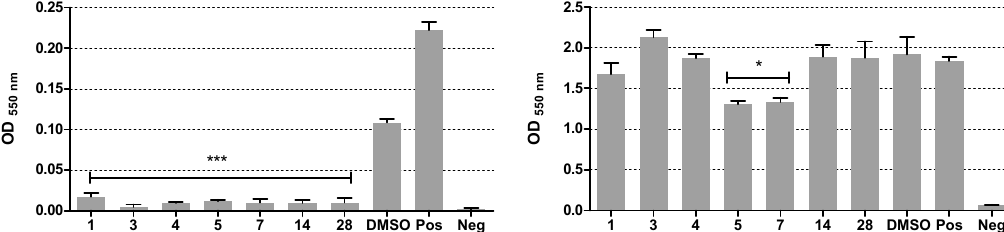
Figure 5. Antibiofilm activity of the selected chalcones on biofilm formation (left panel) and disruption (right panel). Values are reported as mean ± SD. Biofilm formation: *** p < 0.0005 for chalcones 1 , 3 – 5 , 7 , 14 , and 28 vs. DMSO/positive control. Biofilm disruption: * p < 0.05 for chalcones 5 and 7 vs. DMSO/positive control. The negative control consists of the medium only.